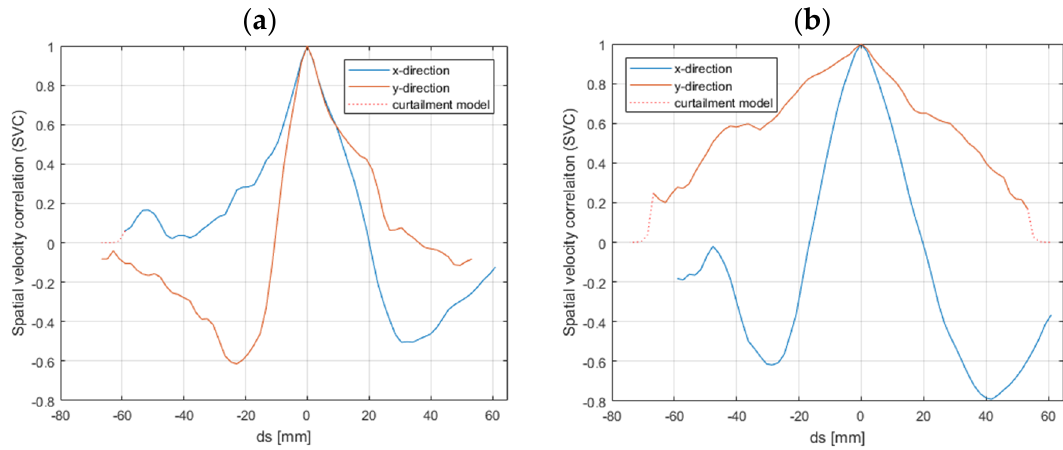
Figure 6. Spatial velocity correlation (SVC) in x and y directions for VP 1 for ( a ) x-component and ( b ) y-component.